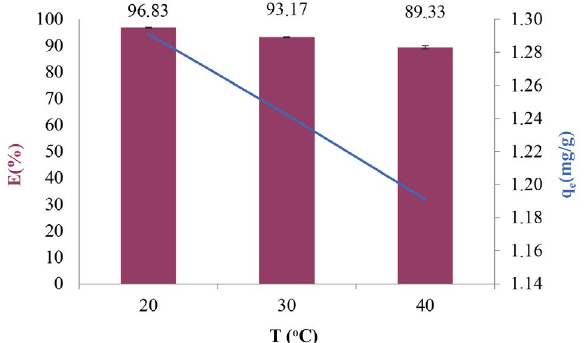
Figure 6. Effect of the temperature, standard deviations calculated from measurements from nine parallel results, where E-efficiency of adsorption, q e -maximum adsorption capacities at equilibrium (C i = 20 mg/L, 1.5 g, 160µm, 700 rpm, pH = 6.0 ± 0.2, T = 20-40 ± 1 °C).